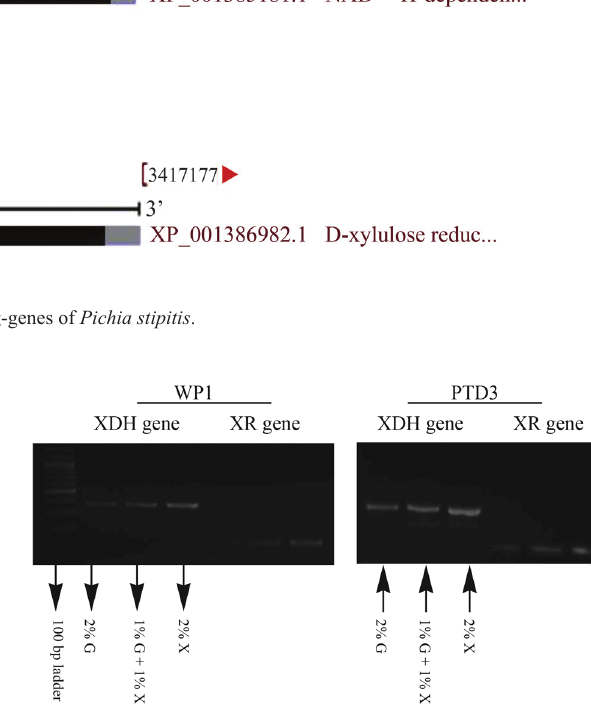
Figure4 -WP1andPTD3XR/XDHgene-expressionincellsgrownin2% glucose (lanes 1,4,7,10), 1% glucose+1% xylose (lane 2, 5, 8,11) and 2% xylose (lanes 3,6,9,12). Lanes 1-6: WP1gene expression; Lanes 7-12: PTD3 gene